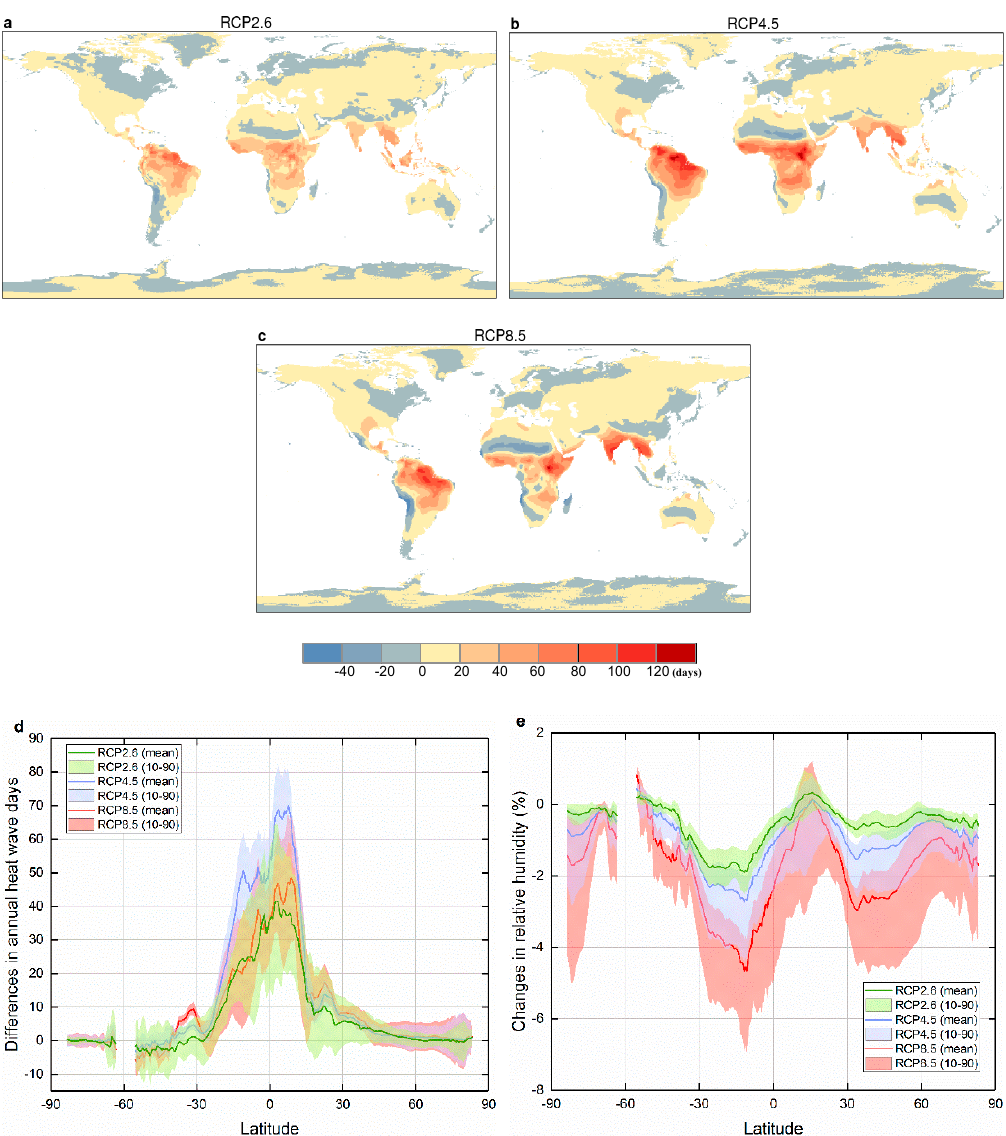
Figure 3. The spatial distributions of difference in annual total WHWDs and THWDs during 2076–2095 under ( a ) RCP2.6, ( b ) RCP4.5, and ( c ) RCP8.5. ( d ) shows the variation with latitude of the difference over land during 2076–2095 under all three scenarios. ( e ) shows the variation with latitude of the change in relative humidity during 2076–2095, relative to mean values between 1986 and 2005. Bold lines are the multi-model averages, shaded areas are the 10–90% expected ranges of the CMIP5 GCMs used.